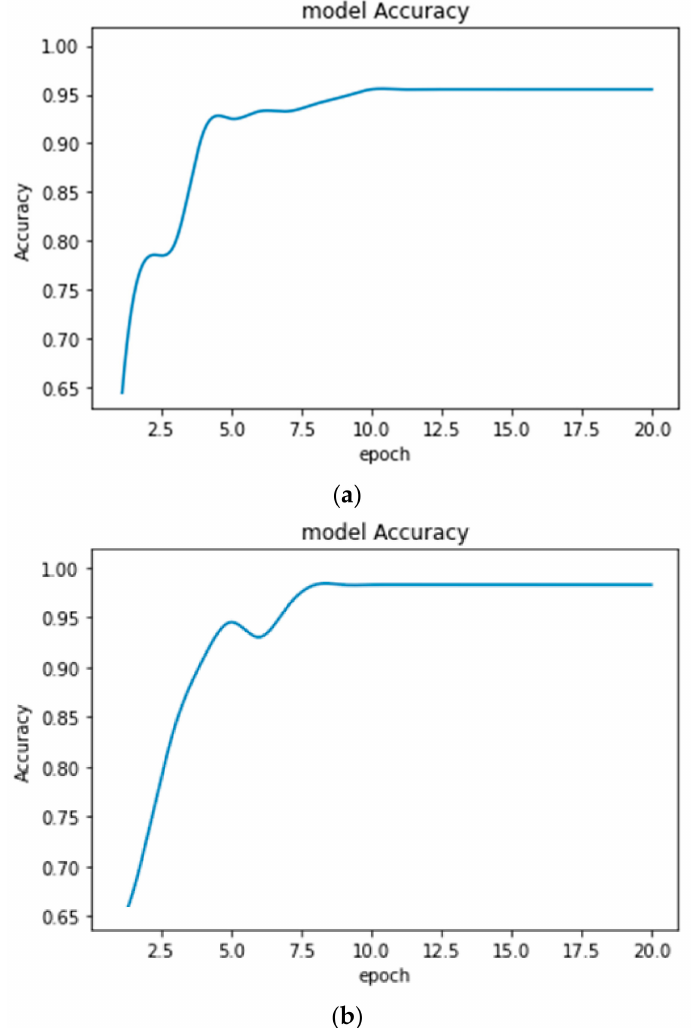
Figure 11. Accuracy plots obtained for EEG NSC-ND data classification ( a ) with earlier form of CE (Accuracy = 95.01%) and ( b ) with improved CE (Accuracy = 98.13%).